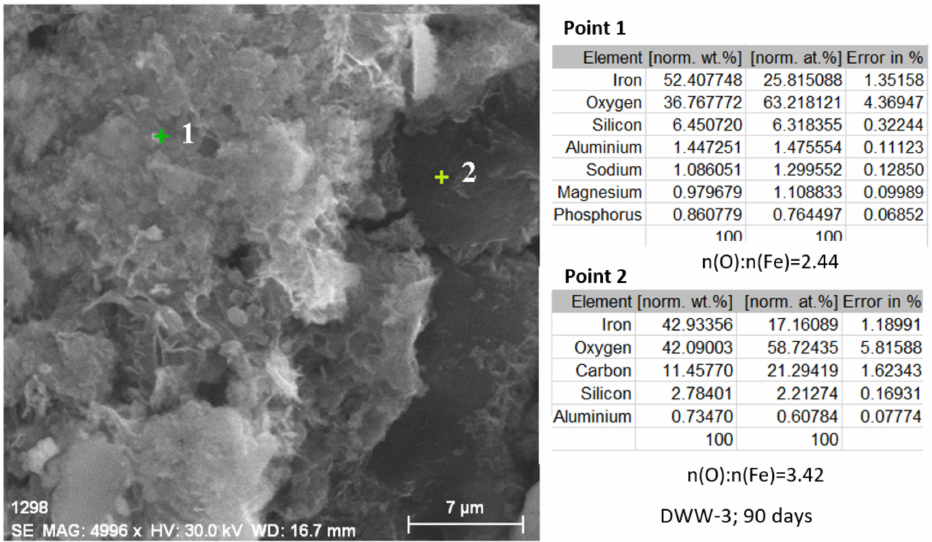
Figure 27. Punctual compositions on the sample surface immersed for 90 days in